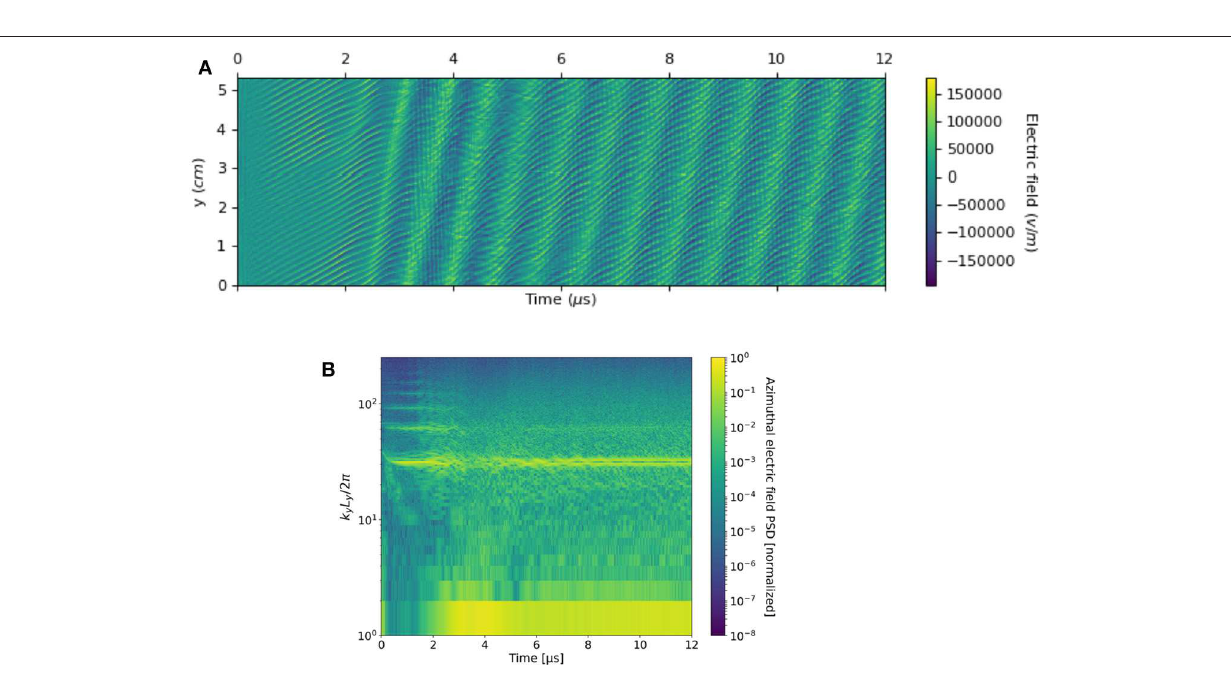
FIGURE 6 | Temporal evolution of (A) the azimuthal profile of the oscillating electric field E y and of (B) the corresponding distribution of power into wavenumber components S Ey ( k y